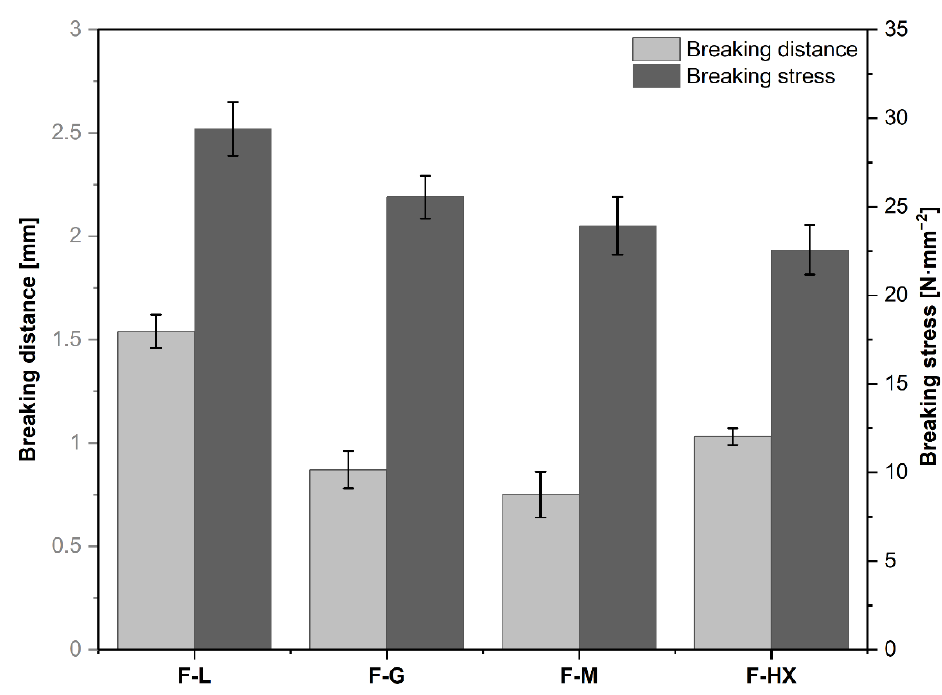
Figure 2. Mechanical properties of extruded filaments. Breaking distance and breaking stress were determined in a three-point-bend test ( n = 5). Data are presented as mean ± standard deviation. Table 4. 3D-printing parameters for each formulation of 3D-printed tablets including results regard- ing feedability and printability of the filaments.